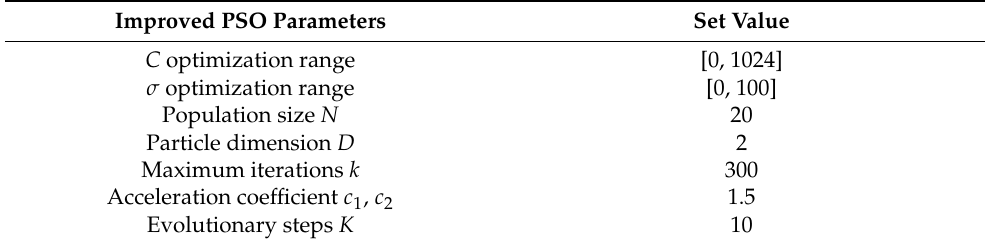
Table 4. Parameter settings of improved PSO